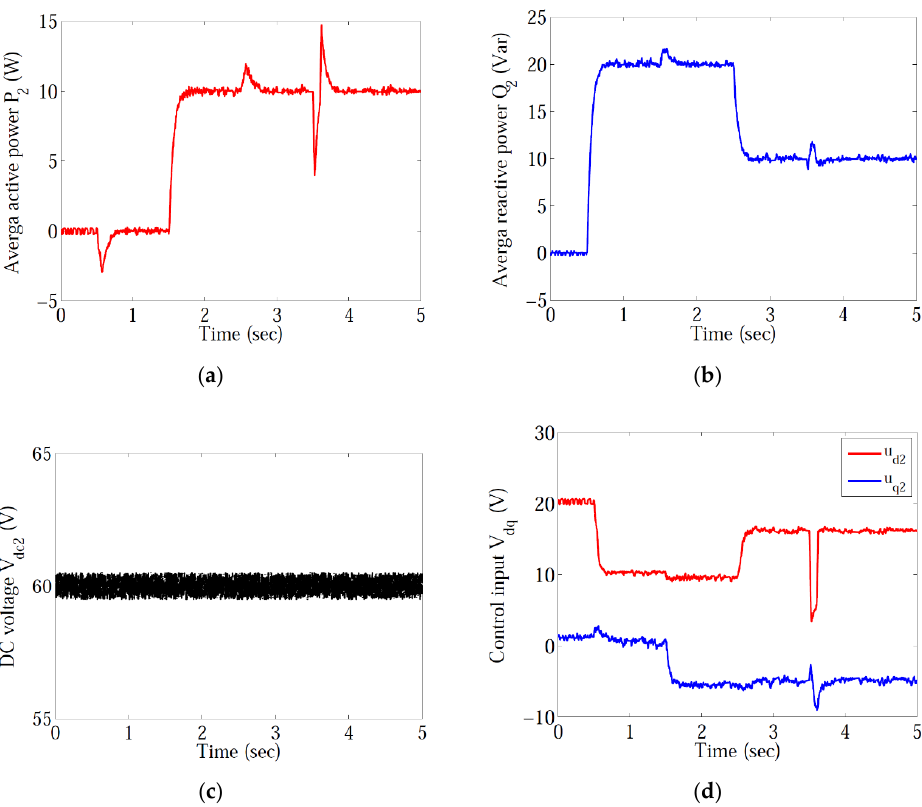
Figure 9. System responses obtained in the inverter controller experiment. ( a ) Average active power 𝑃 2 ; ( b ) average active power 𝑄 2 ; ( c ) DC voltage 𝑉 dc2 ; ( d ) control input 𝑉 dq .